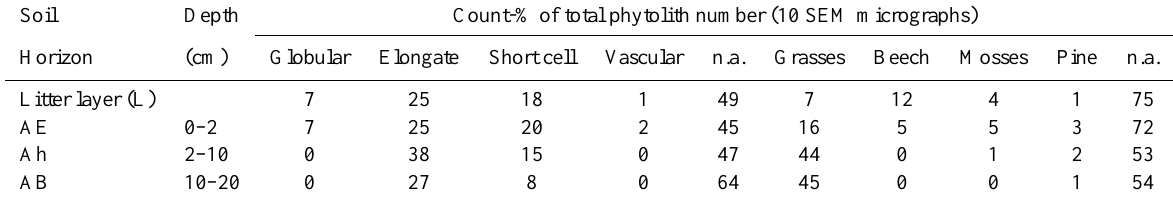
Table 2b. Morphological description and identification of phytoliths; n.a.=not assignable. Soil